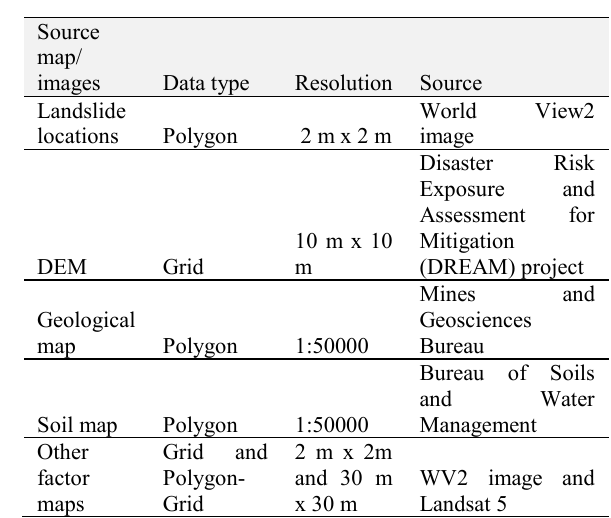
Table 1. Spatial data layers used in this study Six landslide conditioning factors were derived from the DEM using ArcMap Spatial Analyst: elevation, slope angle, slope aspect, plan curvature, profile curvature and distance to drainage. Three factors were derived from scanned maps: (1) lithology, (2) soil type, and (3) distance to fault/ lineament. From the HRSI, three factors were derived: (1) land use/ land cover (LULC) (HRSI data was complemented by Landsat data prior to landslide event), (2) distance to road, and (3)